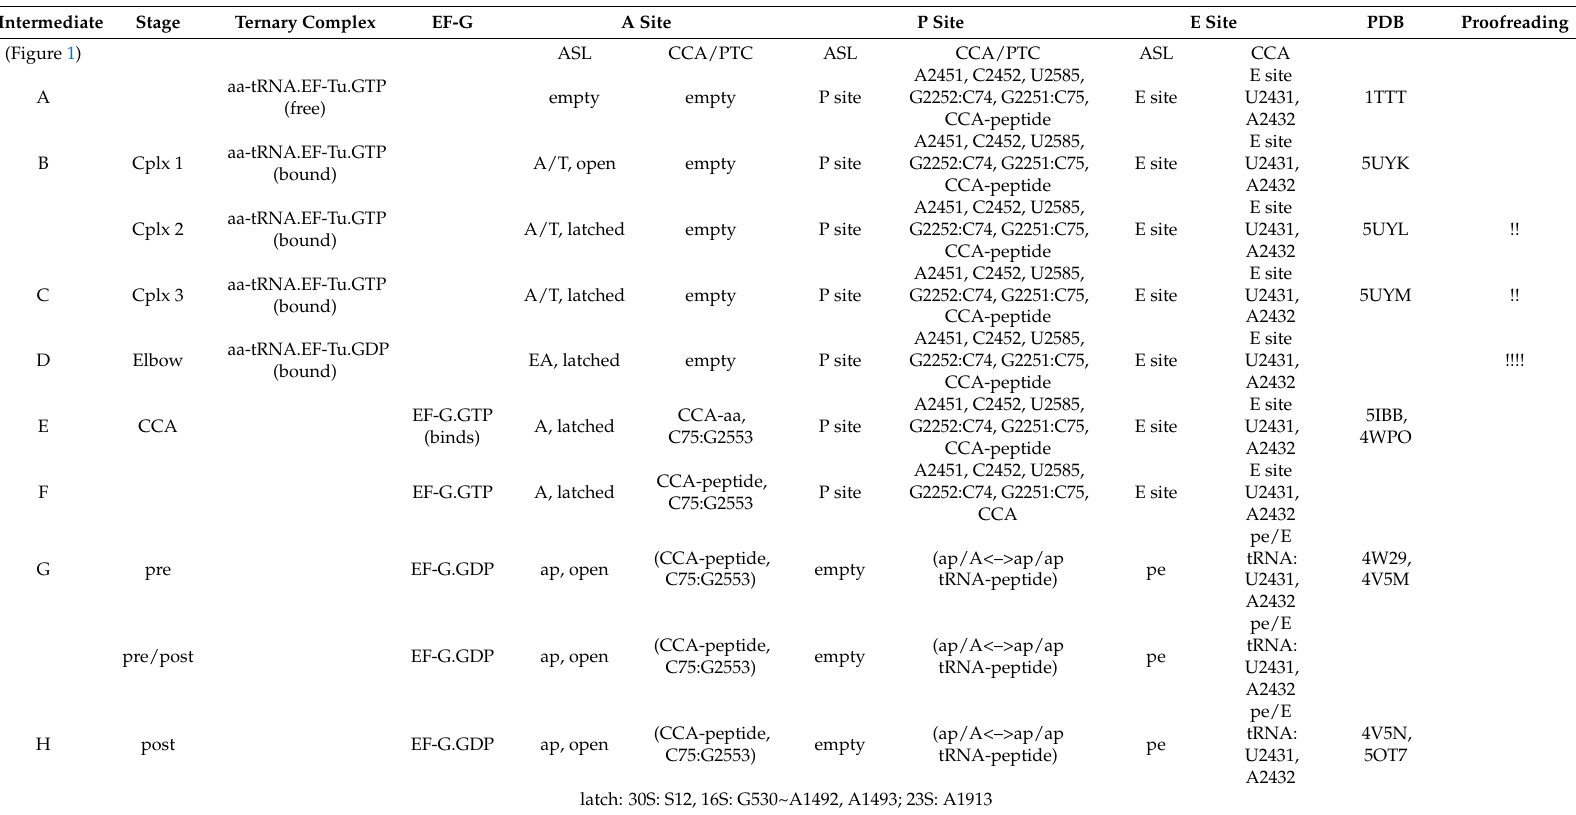
Table 1. Phases of the Translation Elongation